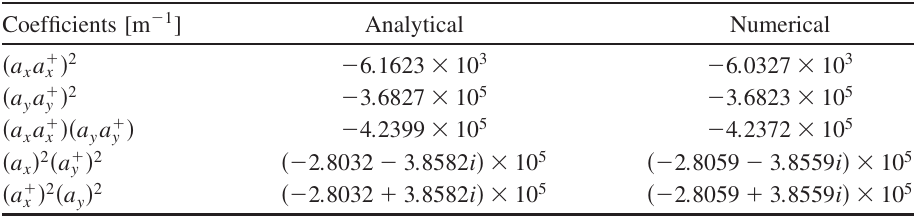
TABLE III. The Lie factor f for a family of sextupoles in the PEP-X achromat. 4 Coefficients [ m (cid:2) 1 ] Analytical Numerical